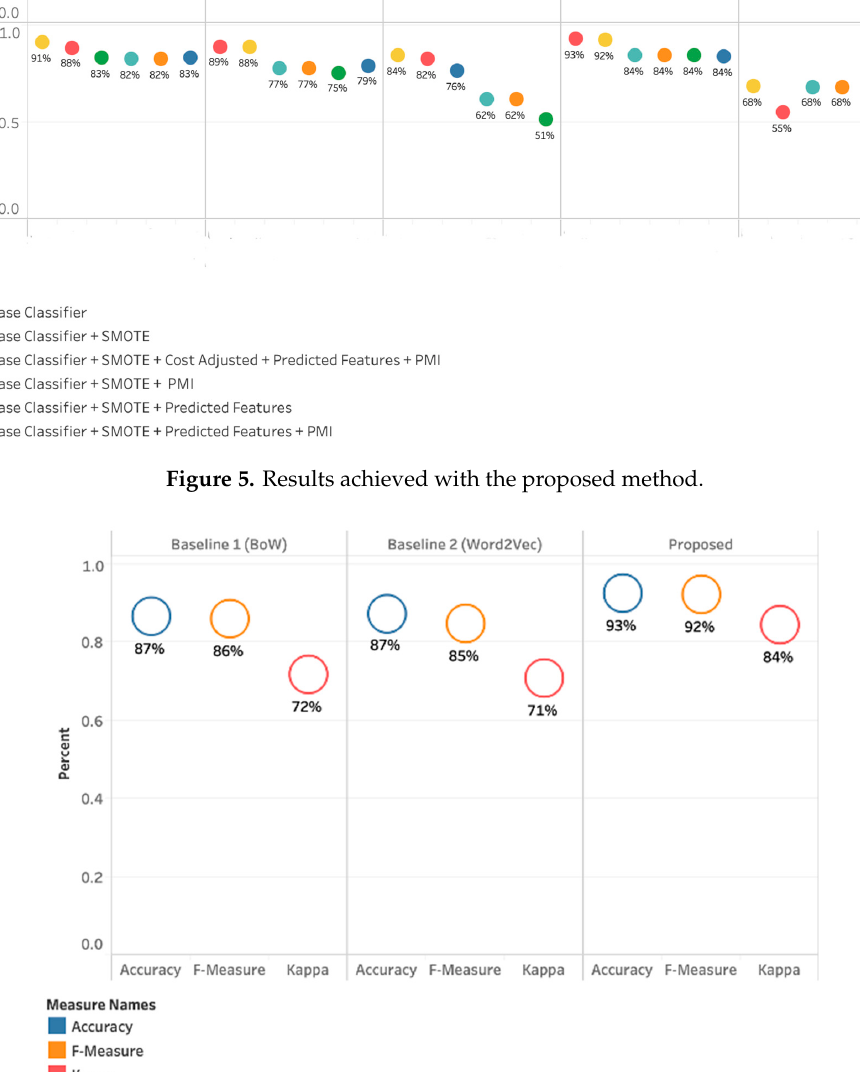
Figure 7. Precision and Recall for baseline and the proposed approach.